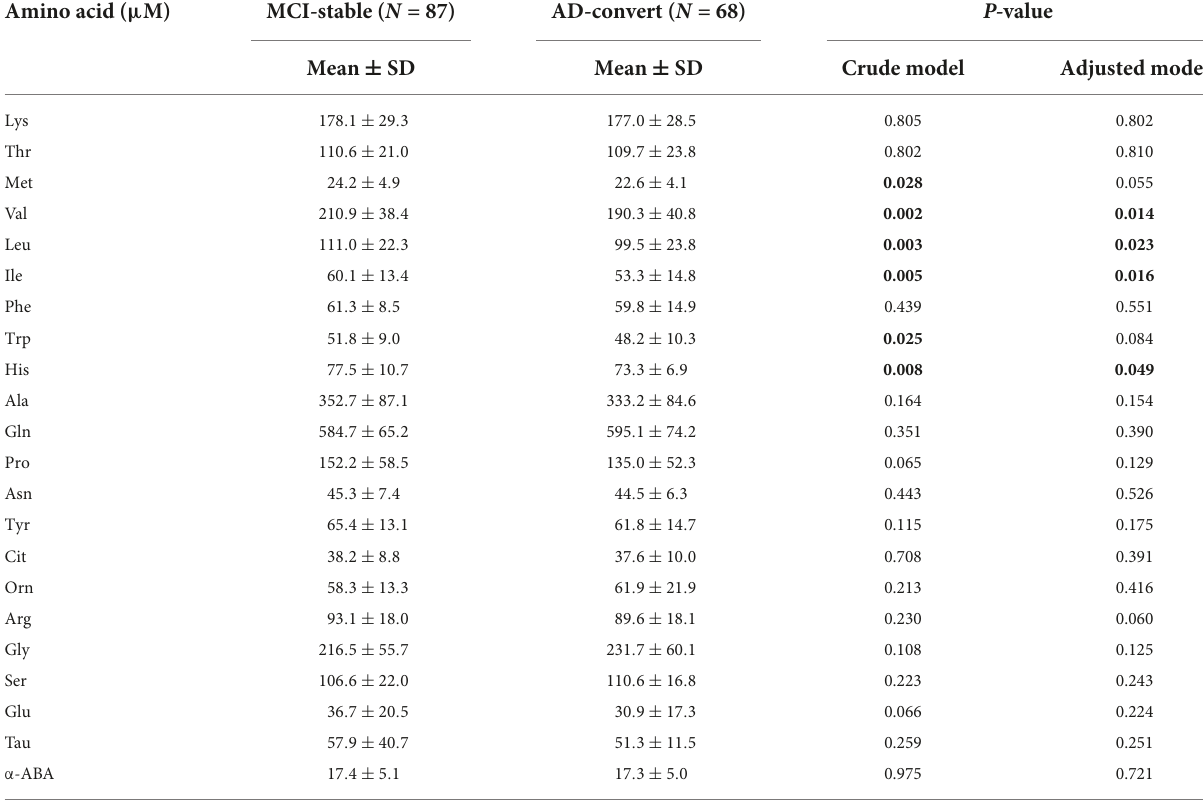
TABLE 2 Comparison of plasma free amino acid (PFAA) concentrations between mild cognitive impairment (MCI)-stable and Alzheimer’s disease (AD)-convert. Amino acid ( µ